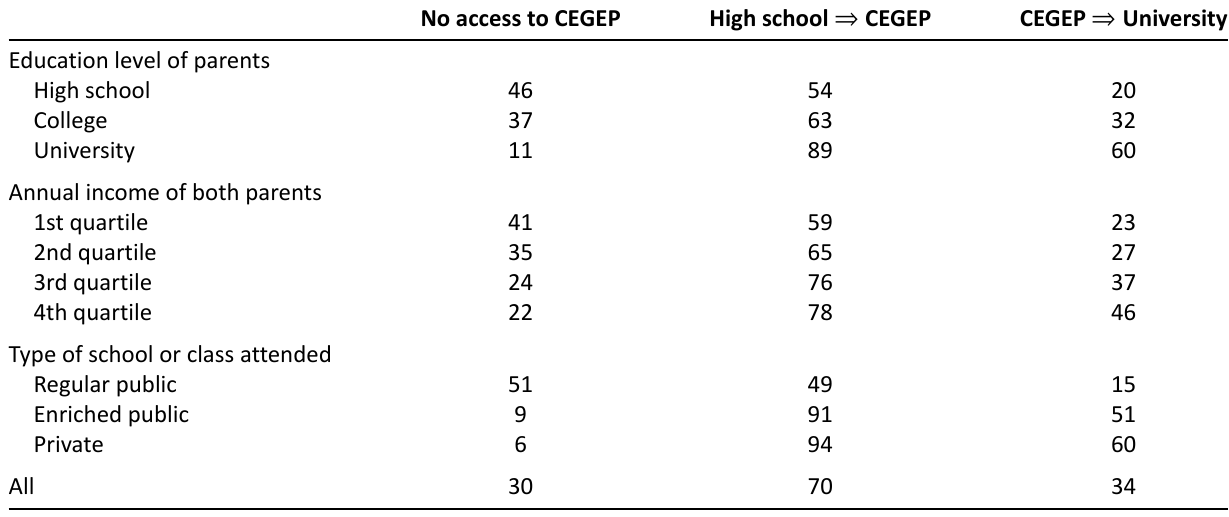
Table 2. Access to higher education according to the social origin of the student and the type of high school attended (%). No access to